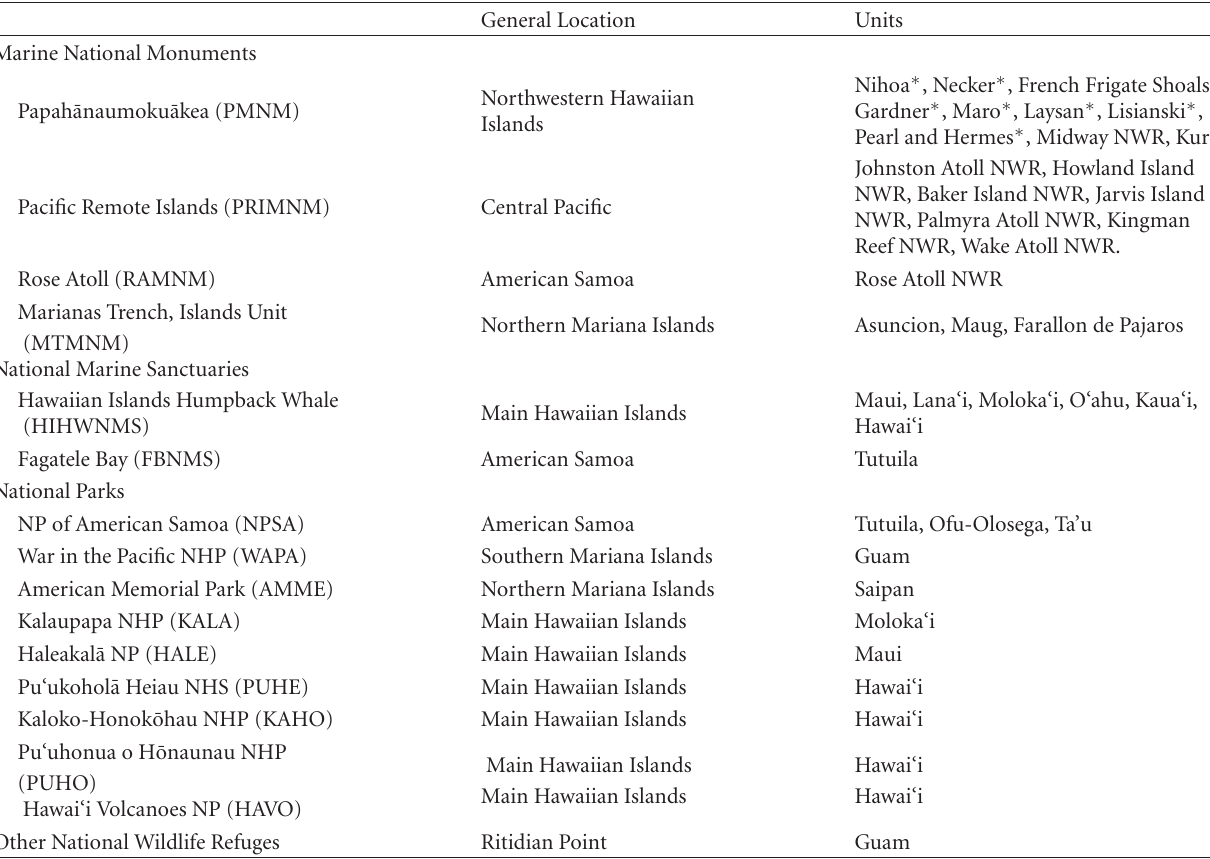
Table 1: Marine National Monuments, National Marine Sanctuaries, National Wildlife Refuges, and National Parks with coral reef habitat in the US